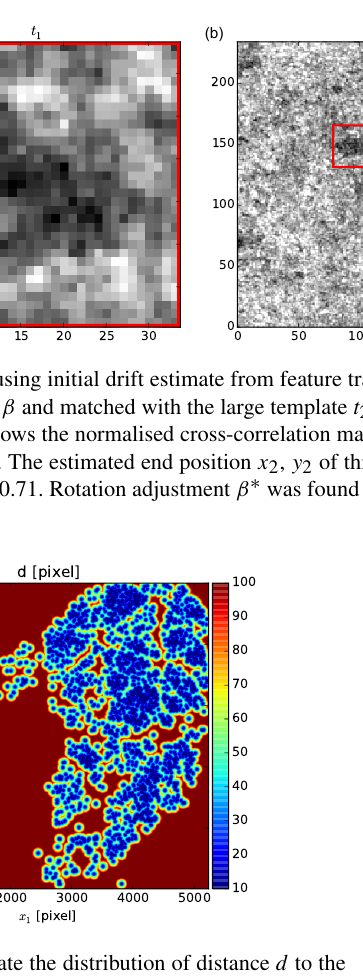
Figure 8. Example to illustrate the distribution of distance d to the closest feature-tracking vector using image pair Fram Strait in HV polarisation. Values outside the range d min ≤ d ≤ d max are set to d min = 10 and d max = 100. The points with value d min represent the start positions x 1f , y 1f of the feature-tracking vectors on the co- ordinate system x 1 , y 1 of SAR 1 . The figure depicts the matrix that the algorithm considers for the distribution of d